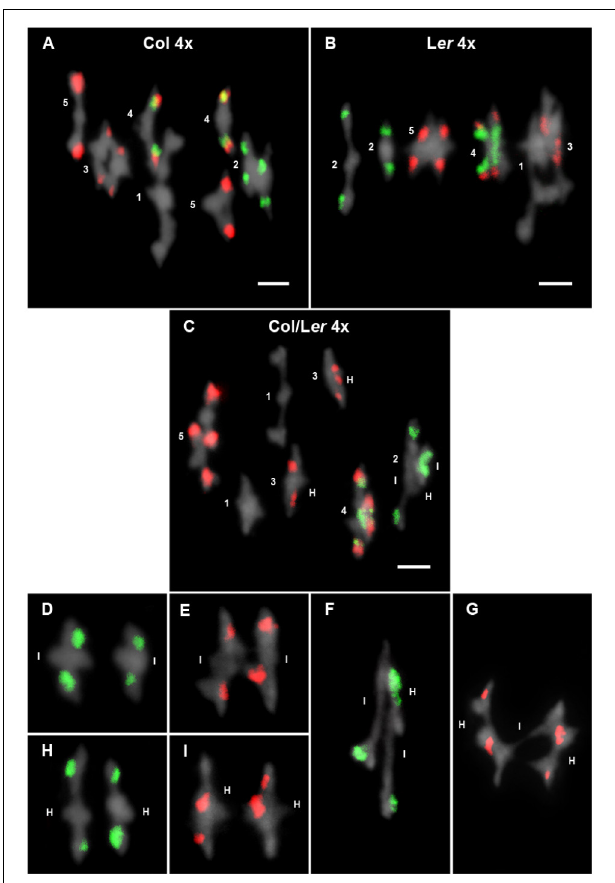
FIGURE 3 | Cytological analysis of autotetraploid cells at metaphase I. Representative examples of metaphases I from Col 4x (A) , L er 4x (B) , and Col/L er 4x (C) . Chromosomes are identified by FISH with 5S (red) and 45S rDNA (green) probes. In Col 4x, tetrasomes 1, 2, and 3 appear as quadrivalents, whereas two bivalents are formed in tetrasomes of chromosomes 4 and 5. In L er 4x, only the tetrasome of chromosomes 2 appears as two bivalents. In the hybrid, two bivalents are formed in tetrasomes of chromosomes 1 and 3, whereas the remaining tetrasomes appear as quadrivalents. The figure also includes examples of associations between identical chromosomes in bivalents formed by chromosomes 2 (D) and chromosomes 3 (E) . Examples of associations between homologous chromosomes in bivalents formed by chromosomes 2 (H) and chromosomes 3 (I) . Examples of quadrivalents formed by chromosomes 2 (F) and 3 (G) . Capital letters I and H represent identical and homologous association, respectively. Bars represent 5 µ